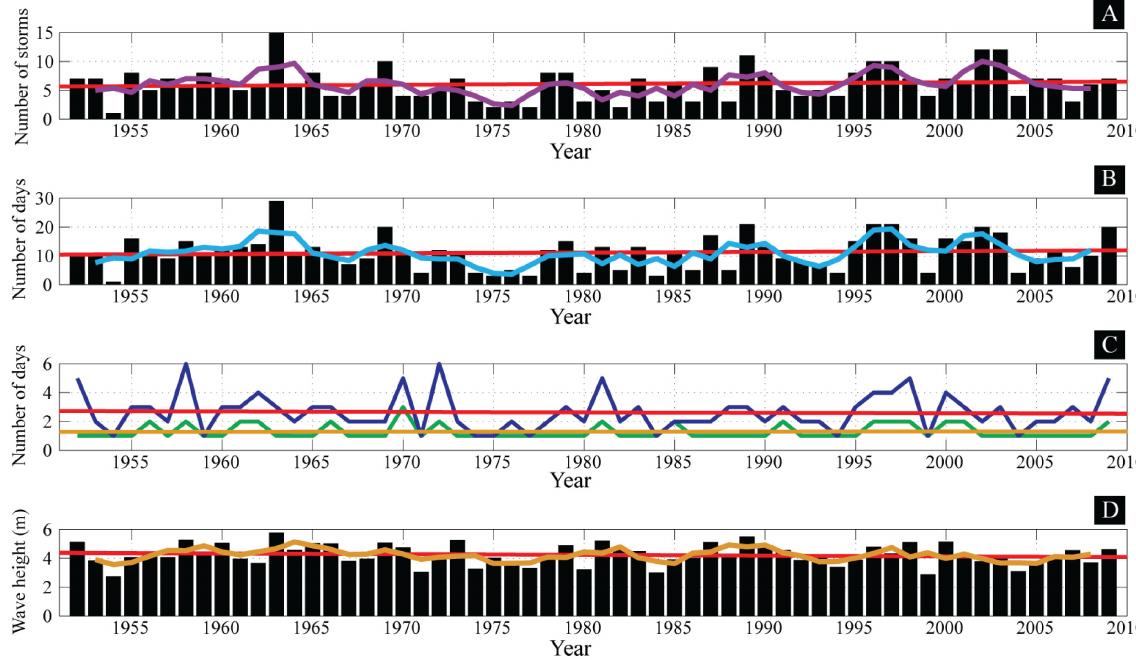
Fig. 3. Variations in annual storm parameters and extreme wave height percentile. Legend: (A) annual number of storms (black bars), moving average data (3 points – purple curve) and linear regression line (red line); (B) annual number of days with storms (black bars), moving average data (3 points – blue curve) and linear regression line (red line); (C) annual maximum individual storm duration (blue curve), annual mean individual storm duration (green curve), annual maximum individual storm duration linear regression line (red line) and annual mean individual storm duration linear regression line (brown line); (D) annual H s99 . 8 (black bars), moving average data (3 points – brown curve) and linear regression line (red line).